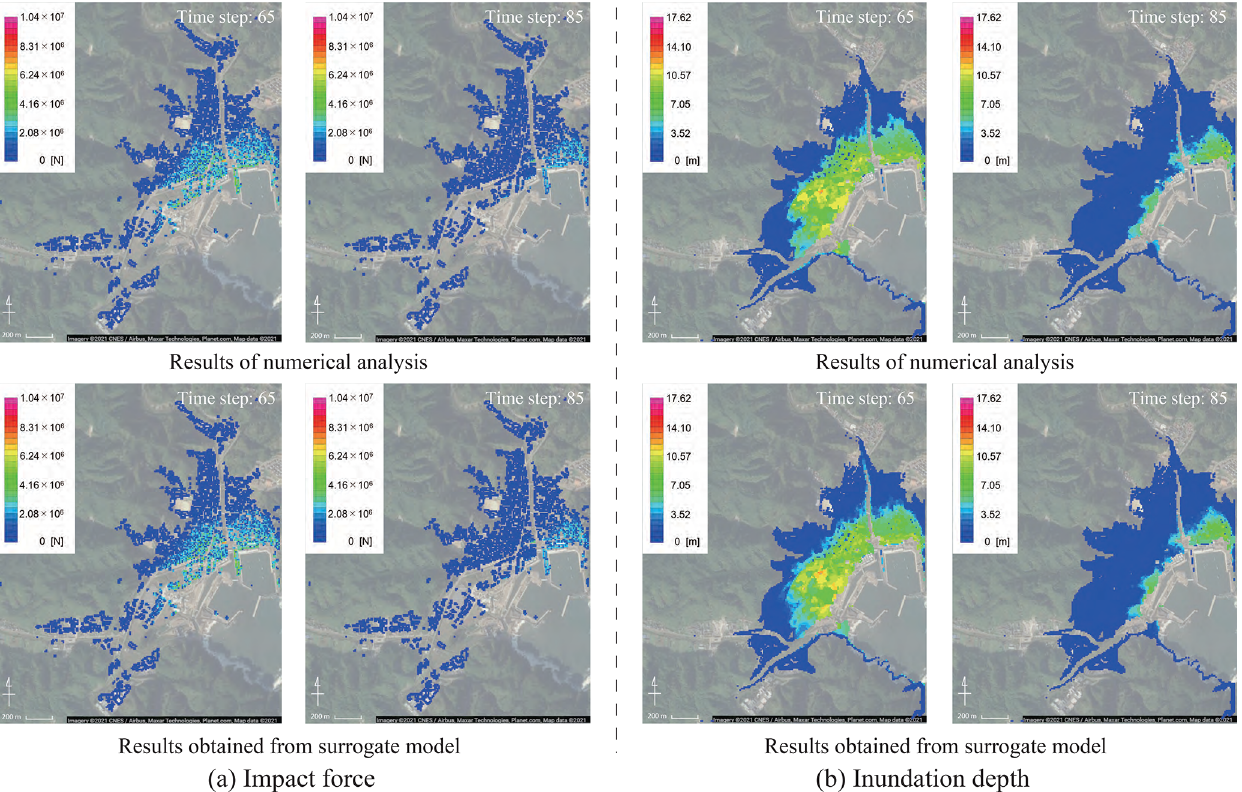
Figure 15. Snapshots of the results obtained from numerical analysis and those reconstructed by using spatial modes (© Google Maps).